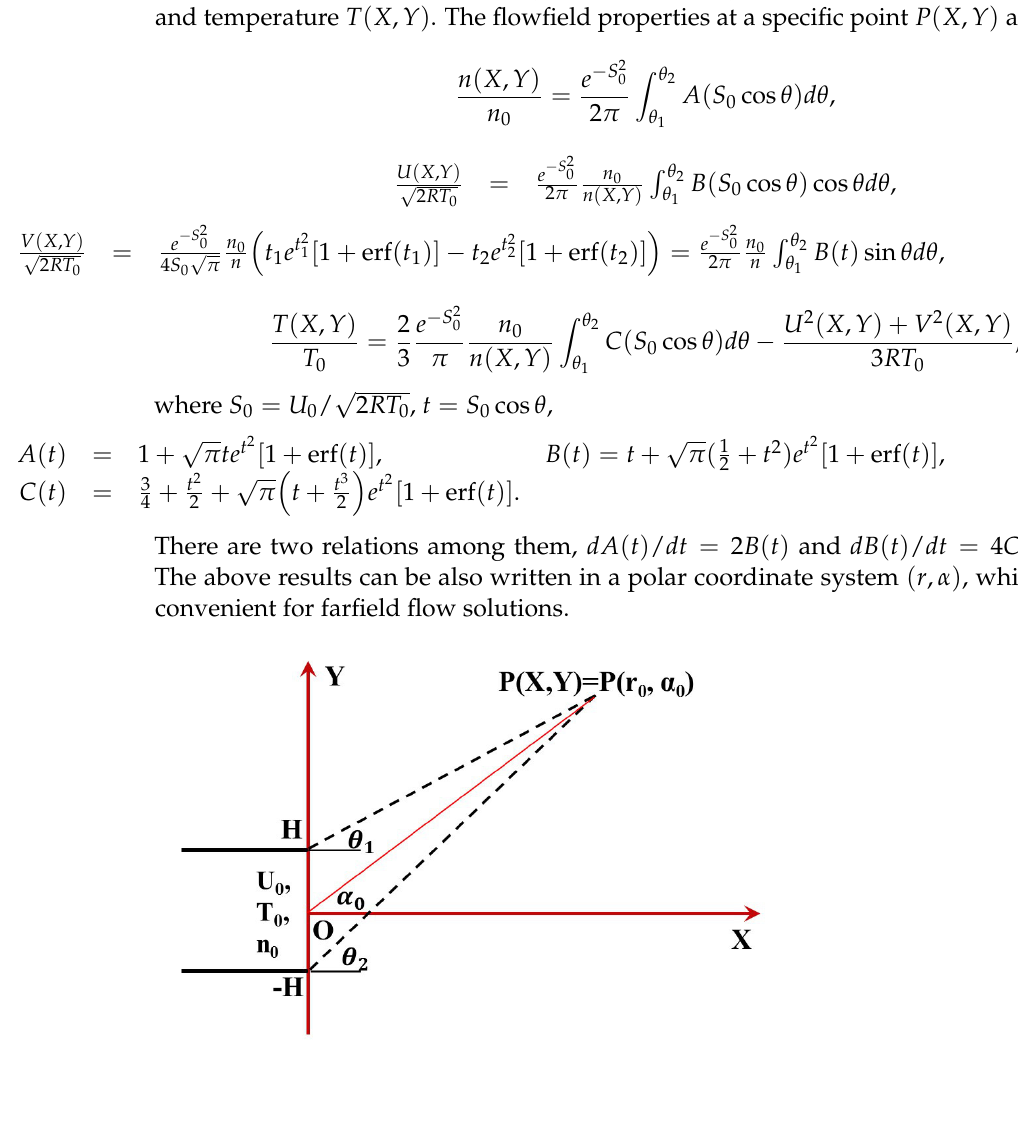
Figure 1. Illustrations for the problem of a neutral and collision-less jet expanding into a